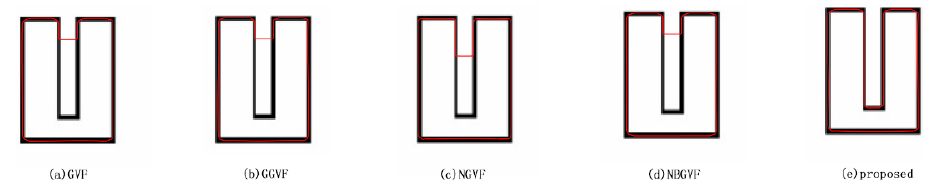
Figure 6. LTI (Long and Thin Indentation) convergence results of all models.